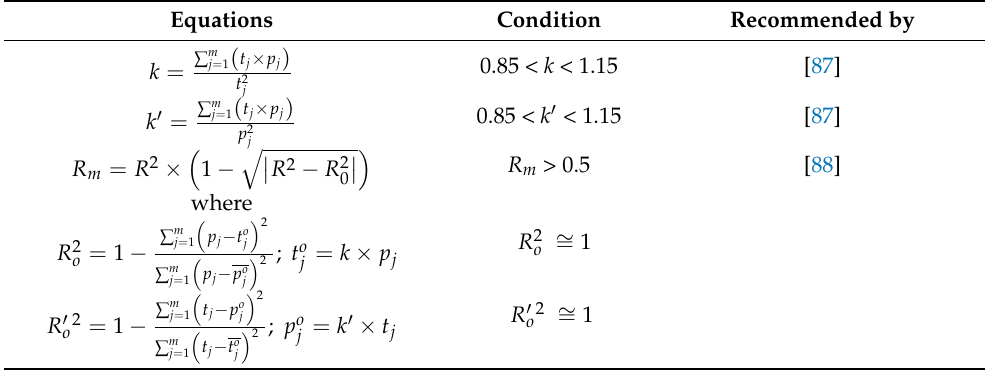
Table 5. Statistical metrics suggested in literature. Equations Condition Recommended